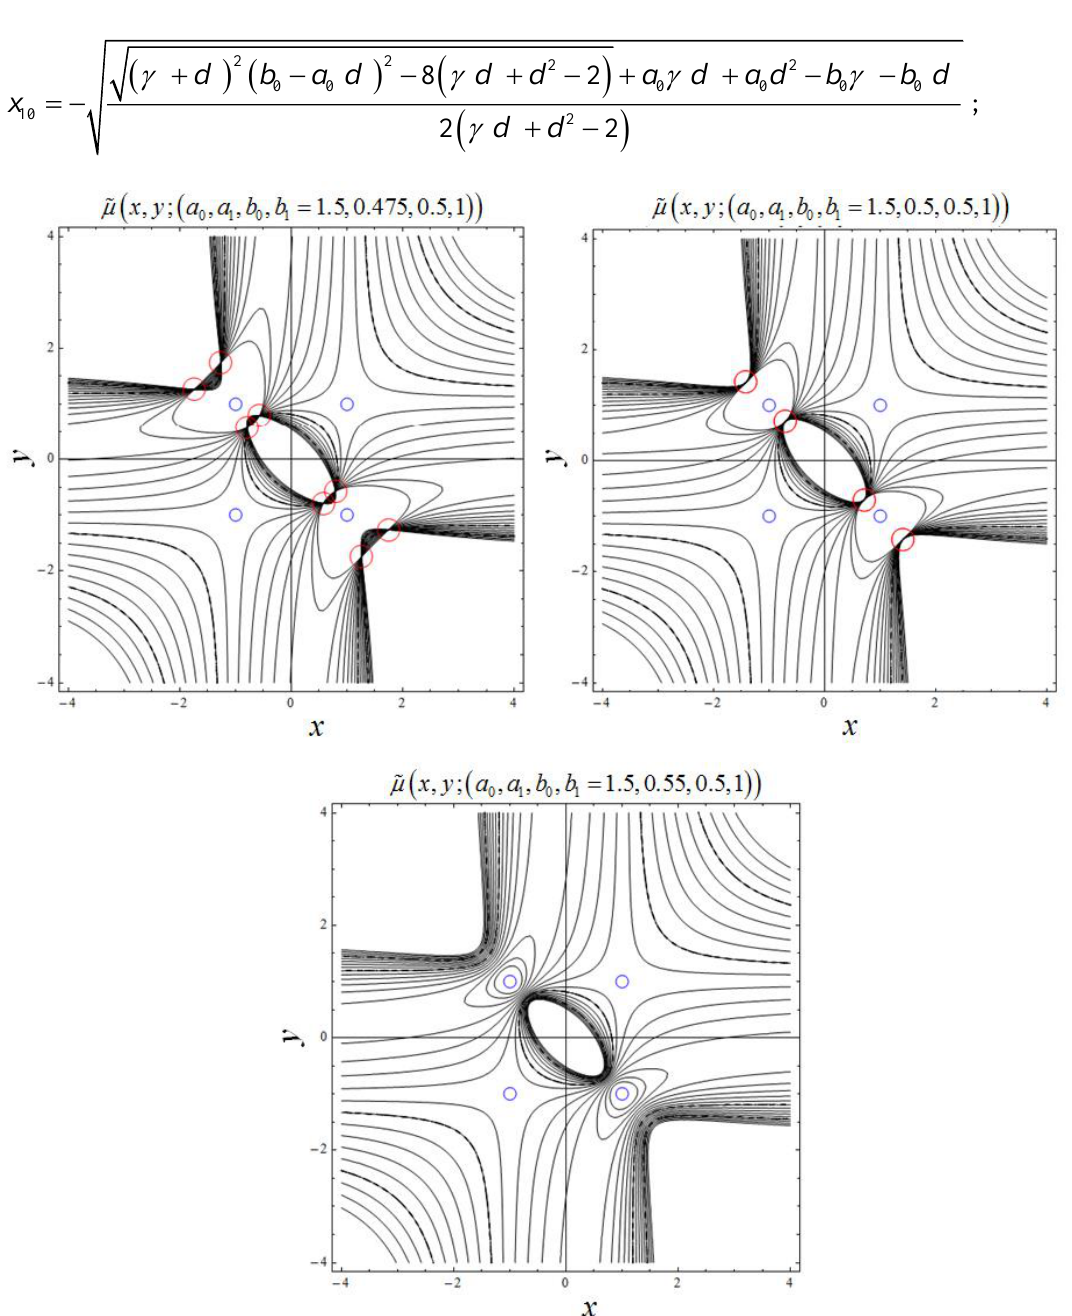
Figure 1. The level sets, the fixed points, the 2-periodic points, and the real base points of the integral (12) for ,,, = aabb parameter values  ,,, = aabb   1.5,0.475,0.5,1 (the diagram in the first row-left),  0101 0101   1.5,0.5,0.5,1 (the diagram in the first row-right), and   , , , = a a b b   1.5,0.55,0.5,1 (the diagram in 0 1 0 1 the second